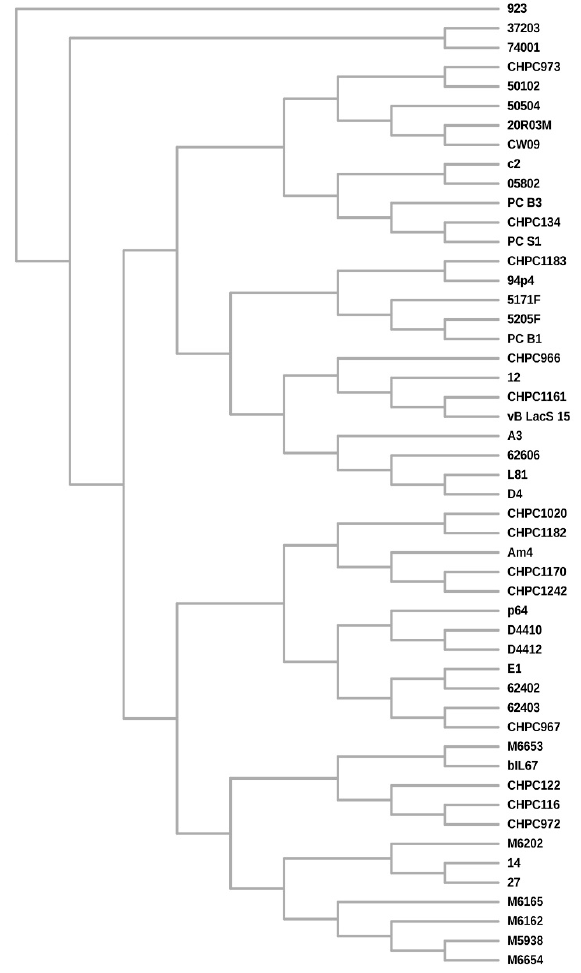
Figure 6. Cladogram of the Ceduovirus phages based on the reconciled trees for the following proteins: holin, lysin, ERF-like recombinase, DNApol, tail fiber (GP2 and GP4), major capsid (GP14). All-against-all pairwise alignments of nucleotide sequences of the early transcribed gene regions revealed 85%–99% of identity (with 76%–100% coverage) among the studied phages. Within this region, two modules encoding putative recombination (ERF-like: pfam 04404 and SSB: pfam 16773) and two to three replication (DNApol) protein products (one with the RecA-like_NTPase superfamily domain cl28885) were annotated by RAST coupled with BLASTp and HHPRED